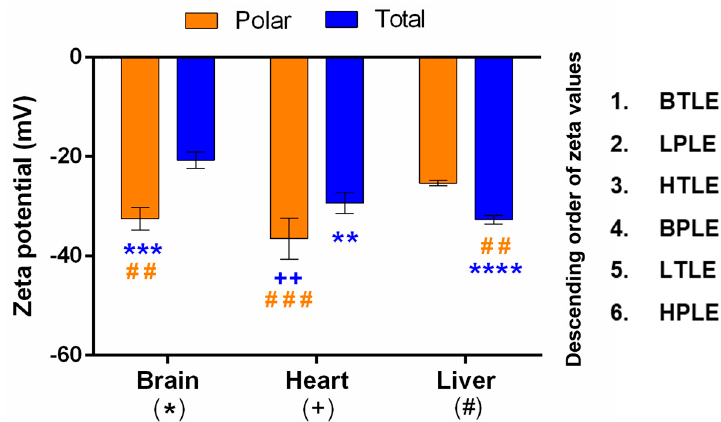
Figure 6. Zeta potential of tissue-specific lipid extracts (in liposome suspensions). All data represent the mean value of zeta potentials with three replicates. Significant differences are marked with symbols respectively: * significant compared to brain lipid, + significant compared to heart lipid, and # significant compared to liver lipid. The color of the symbols depicts the comparative polar (orange) or total (blue) extract; **/ ++ / ## 0.001 < p < 0.01, ***/ ### 0.0001 < p < 0.001, **** p < 0.0001 (Graphpad Prism; two-way ANOVA, Sidak’s multiple comparisons test), BTLE — brain total lipid extract, LPLE — liver polar lipid extract, HTLE — heart total lipid extract, BPLE — brain polar lipid extract, LTLE — liver total lipid extract, HPLE — heart polar lipid extract.